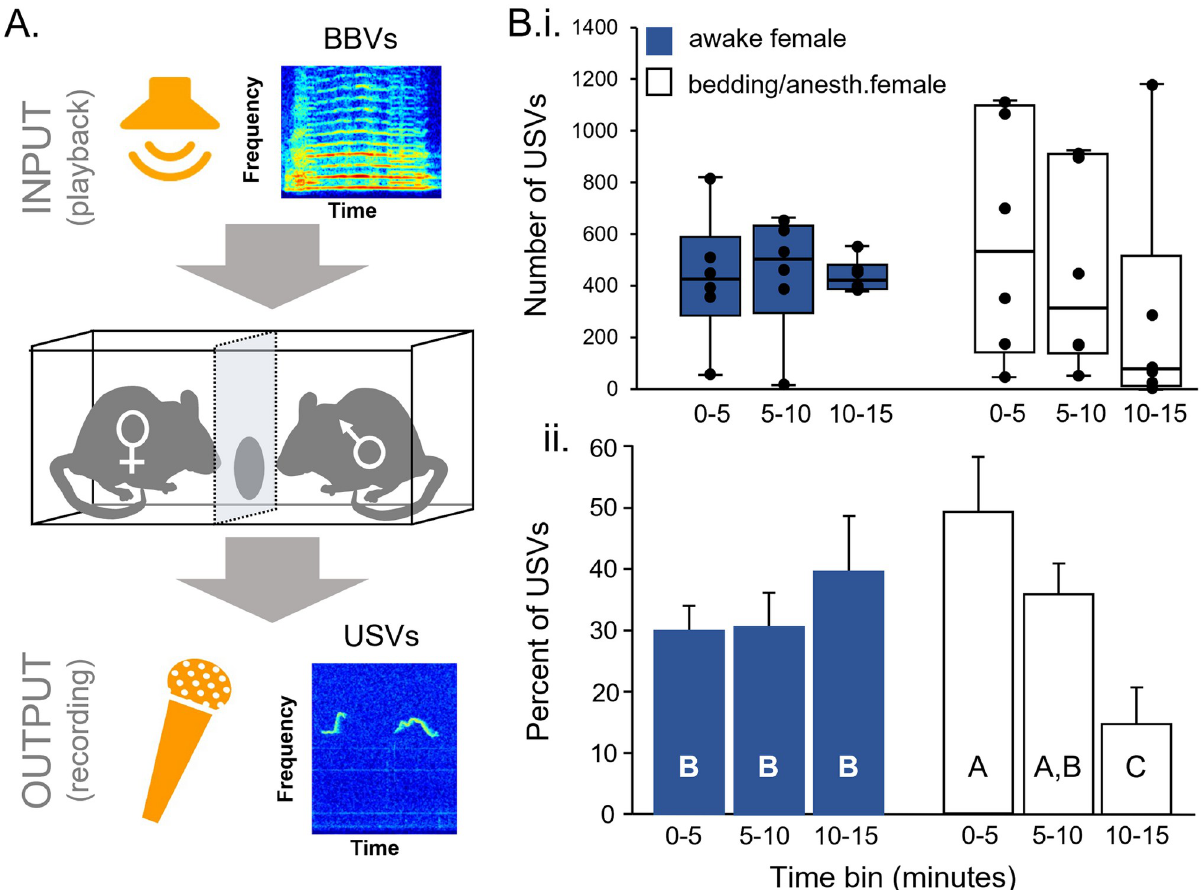
Fig 2. Behavioral assay. A) BBVs are played to a male-female pair separated by a barrier, and USVs and non-vocal behaviors are measured as dependent variables. B) USV production over 15 minutes in the absence of BBV playback, for males placed in a divided cage with awake females (blue: n = 6) or soiled female bedding or anesthetized females (white: n = 6). i) Box and whiskers plots of numbers of USVs within specific time bins. ii) Percentage of USVs within specific time bins, normalized to total USV numbers for individual mice; in each treatment, all three time periods sum to 100% for each interaction. When males are paired with awake females, calls are maintained over time. When males are presented with soiled bedding only, or paired with anesthetized females, calls decline over